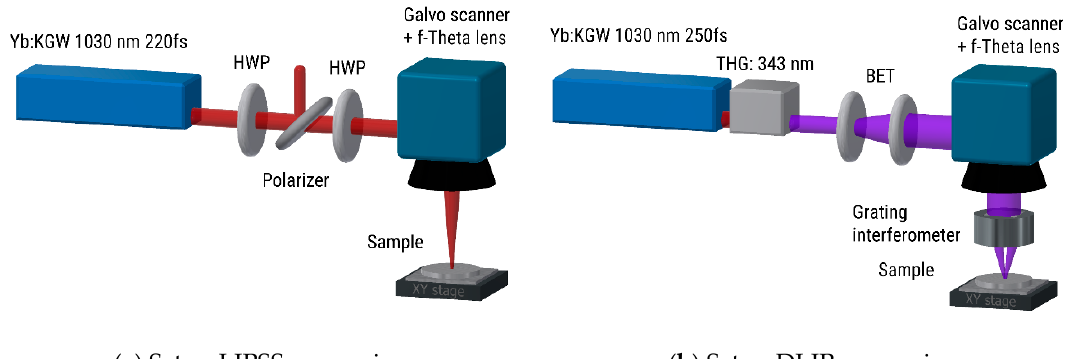
Figure 4. Different approaches for generating grating-like periodic surface structures. ( a ) Setup for processing of LIPSS. ( b ) Setup for direct laser interference patterning (DLIP) processing.